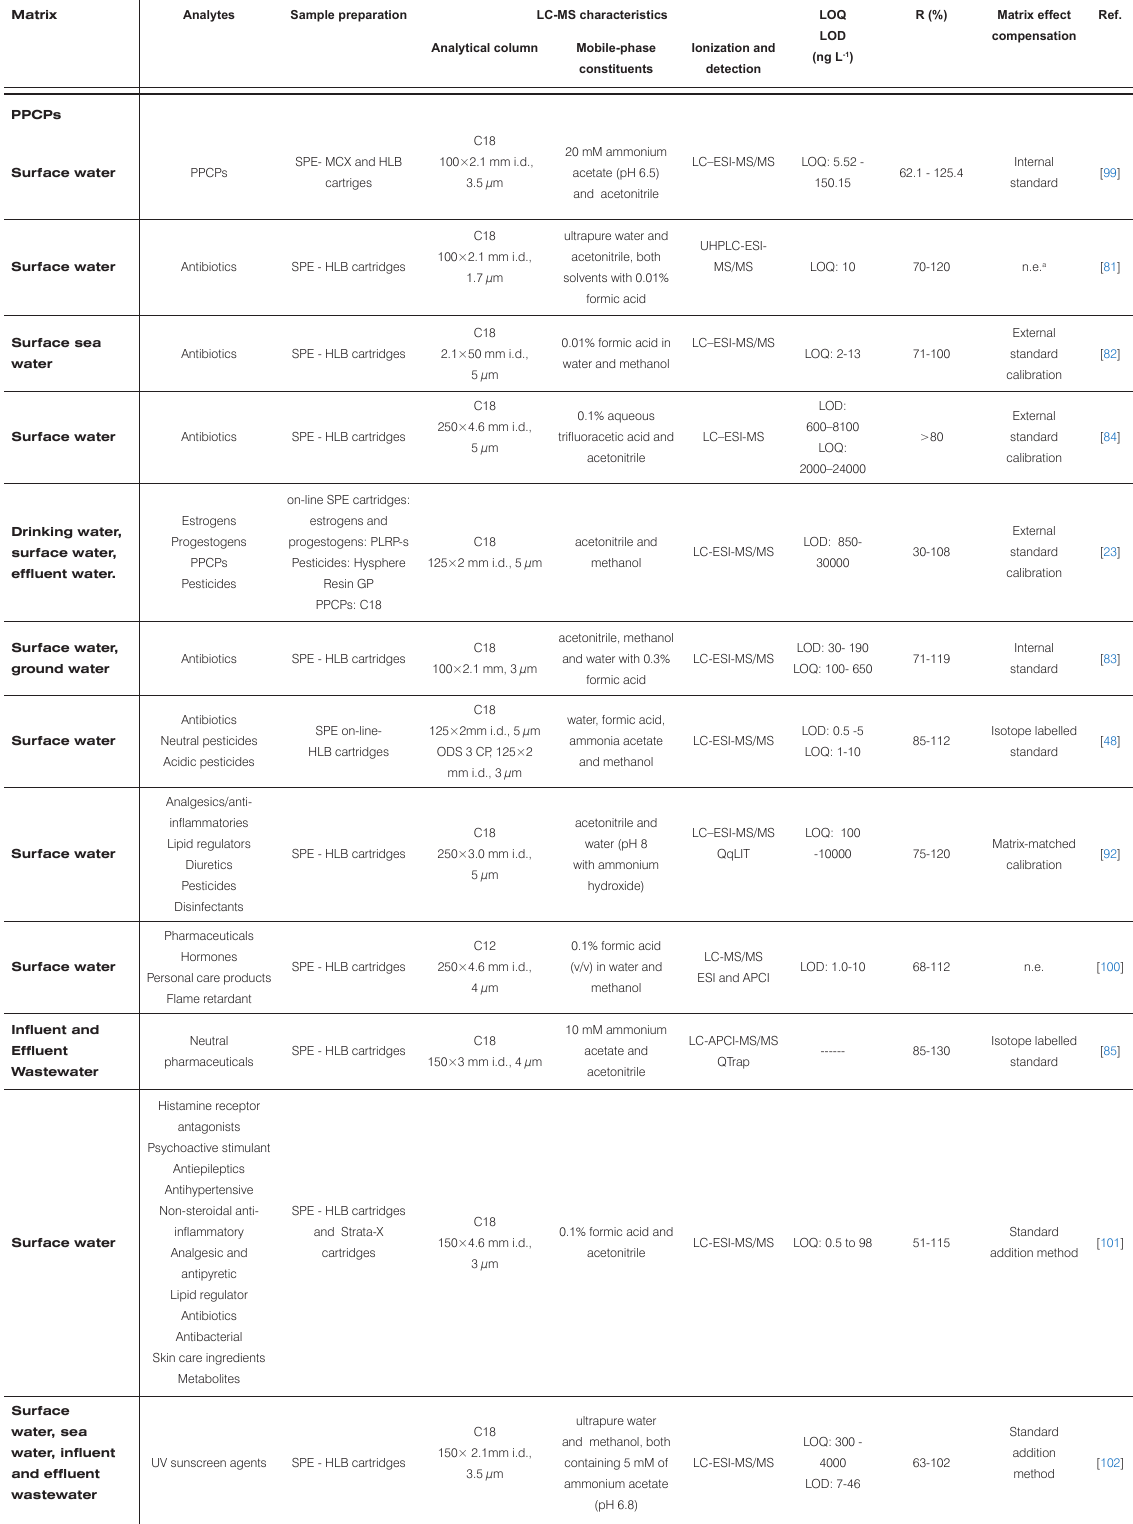
Table 1. Overview of representative LC-MS methods for quantitative determination of PPCPs and pesticides in environmental